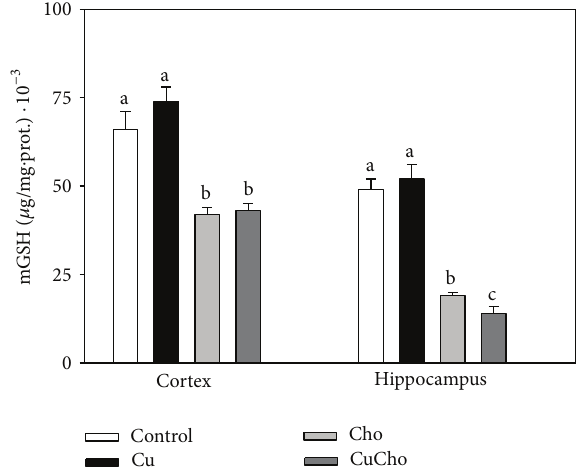
Figure 3: Mitochondrial membrane potential in brain cortex and hippocampus. Treatments are indicated with different colors, con- trol (white bars), Cu (black bars), Cho (gray bars), and CuCho (dark graybars).SampleswereanalyzedasindicatedinSection 2.8.Results are expressed as mean of 10 rats assayed in triplicate ± standard deviation (SD). Significant differences among the experimental groups are indicated with superscript letters (values with distinct letters are significantly different between them, 𝑃 < 0.01 ). Table 1: Caspase-3 activity in brain cortex and hippocampus from the experimental diets. Diets